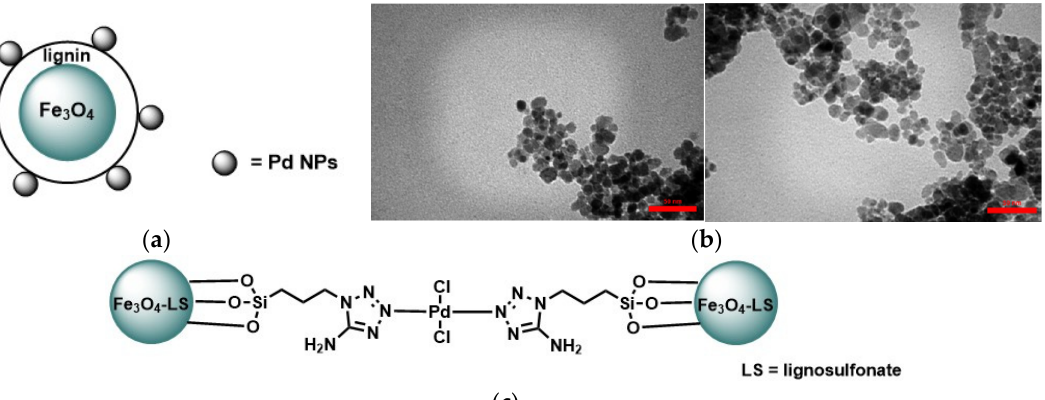
Figure 21. ( a ) Structure of the catalyst Pd NPs@Fe 3 O 4 -lignin prepared by Nasrollahzadeh and Luque et al.; ( b ) TEM images of Pd NPs@Fe 3 O 4 -lignin before reaction ( left ) and after Suzuki-coupling and recycling ( right ) [151]; ( c ) structure of the catalyst based on palladium–tetrazole complex supported